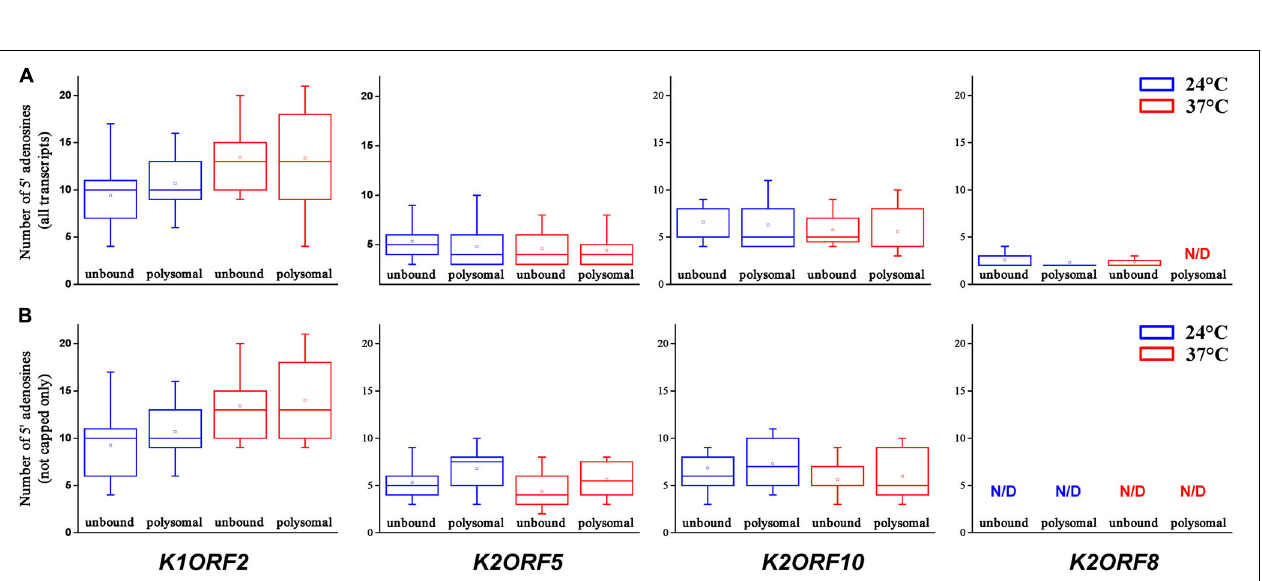
FIGURE 13 | Analysis of the 5 (cid:48) poly(A) leaders of selected pGKL mRNAs in non-polysomal (unbound) and polysomal fractions of the S. cerevisiae CWO4 cdc33-42 ρ 0 [pGKL1/2] strain cultured at the permissive (24 ◦ C, blue bars) and non-permissive (37 ◦ C, red bars) temperatures ( Figure 11 ). The box whisker plot represents the number of templated and non-templated consecutive adenosine nucleotides at the 5 (cid:48) ends of the indicated pGKL mRNAs. The bottom and top of the box indicate the first and third quartiles, respectively. The whiskers indicate the 10th and 90th percentiles. The median is depicted as a solid line, and the mean is depicted as a small square within the box. Outliers are not shown. (A) Lengths of the 5 (cid:48) poly(A) leaders, including their templated and non-templated consecutive adenosine nucleotides calculated for all 5 (cid:48) polyadenylated transcripts. (B) Lengths of the 5 (cid:48) poly(A) leaders, including their templated and non-templated consecutive adenosine nucleotides calculated for the group of the 5 (cid:48) polyadenylated and uncapped transcripts only. In total, 159 sequences obtained by 5 (cid:48) RACE PCR were used for this analysis ( Supplementary Table S13 ). ND, not detected.